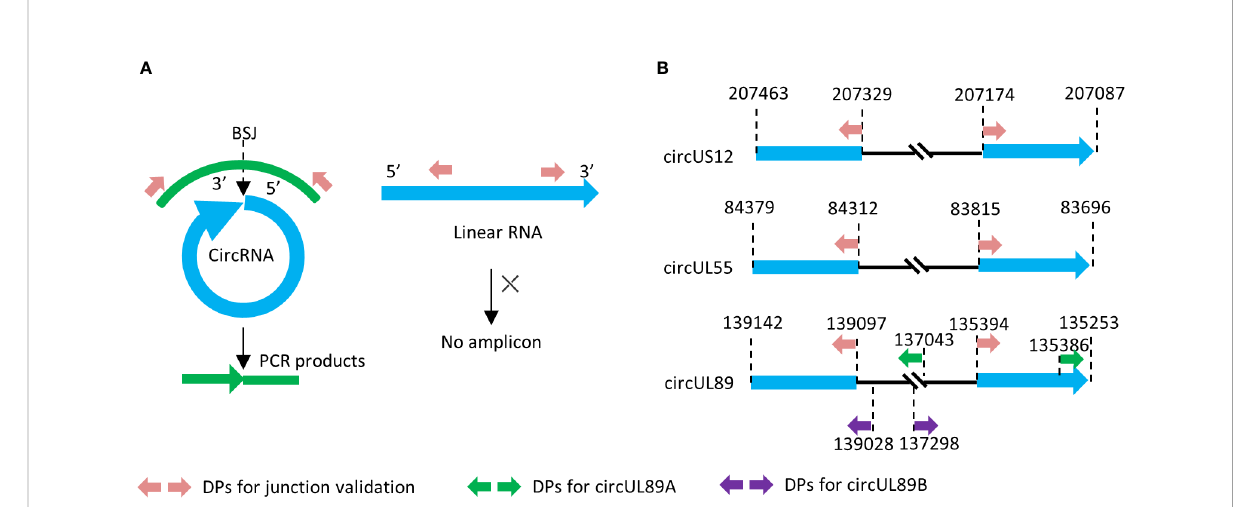
FIGURE 1 Principle of divergent primer design and ampli fi cation. (A) Principle of divergent primer in ampli fi cation of circRNA and linear counterpart. (B) Genome locations of the divergent primes in our